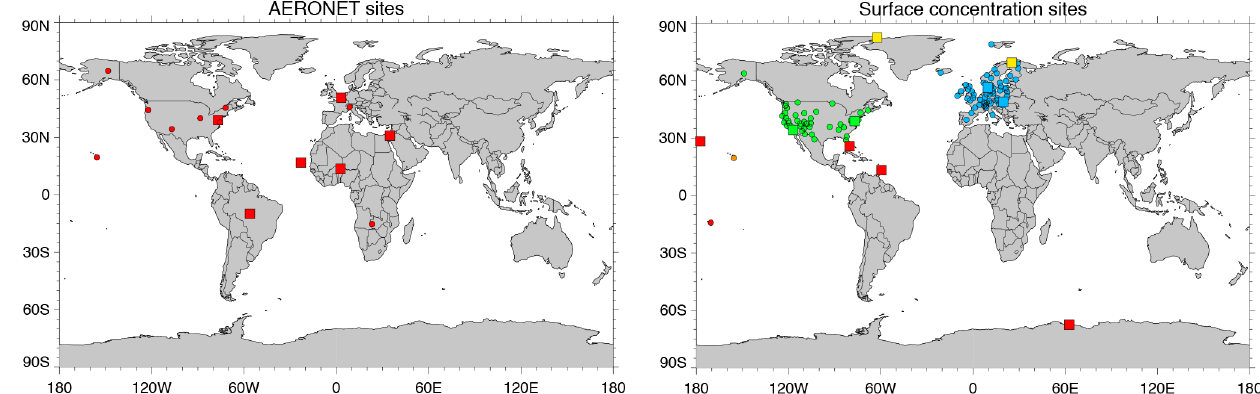
Fig. 3. (left) Locations of 15 AERONET sun photometer sites with at least 12-year AOD data record, and (right) locations of 44 IMPROVE network sites in the US (green), 64 EMEP network sites in Europe (blue), 5 University of Miami sites in the ocean islands (red), University of Hawaii site at Mauna Loa (orange), and 2 Arctic sites (yellow) with at least 15-year data records for at least one aerosol quantity (e.g., sulfate) except the Mawson Station on the Antarctic coast, which had only 9years of measurements. Mawson is included for its unique remote location. The sites where data are shown in Figs. 7, 8, and 10 are indicated with larger square symbols. (The shorter time span criteria for AERONET is because of its relatively shorter history such that only 3 sites have 15years of data from 1995 to